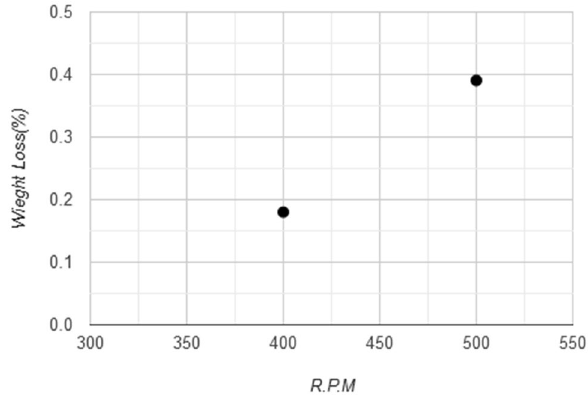
Figure 13. Weight loss ratio with angular velocity for uncoated samples.